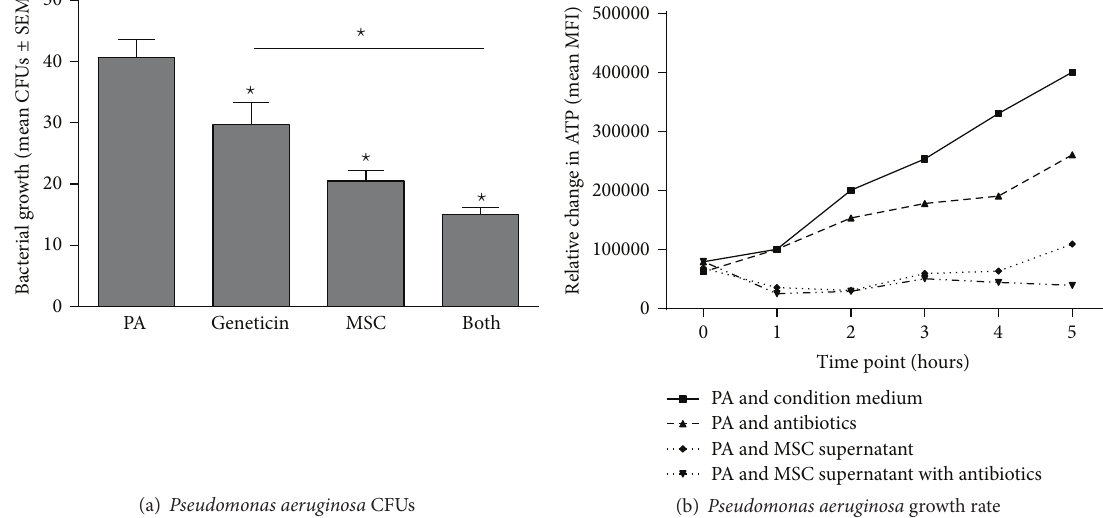
Figure 2: MSCs products decrease Pseudomonas aeruginosa growth. Bone marrow derived hMSCs supernatants were cultured with different dosages of Pseudomonas aeruginosa with and without the addition of geneticin (100 𝜇 g/mL). Aliquots of the bacteria were streaked onto TSA plates for CFUs (a) or evaluated for ATP production (b). hMSC supernatants ( 𝑛 = 8 different donors) significantly decreased both Pseudomonas aeruginosa growth kinetics ( 𝑃 ≤ 0.05 ) and CFUs ( 𝑃 ≤ 0.05 ). Geneticin was used as a positive control which also significantly decreased both CFUs ( 𝑃 ≤ 0.05 ) and growth rate ( 𝑃 ≤ 0.05 ) which was enhanced by the addition of hMSCs ( 𝑃 ≤ 0.05 versus antibiotic alone for both CFUs and growth kinetics). PA = Pseudomonas aeruginosa growth without treatment. Geneticin = treatment with the antibiotic geneticin, +hMSCs = treatment with hMSC derived supernatant, and Both = treatment with both hMSC supernatants and